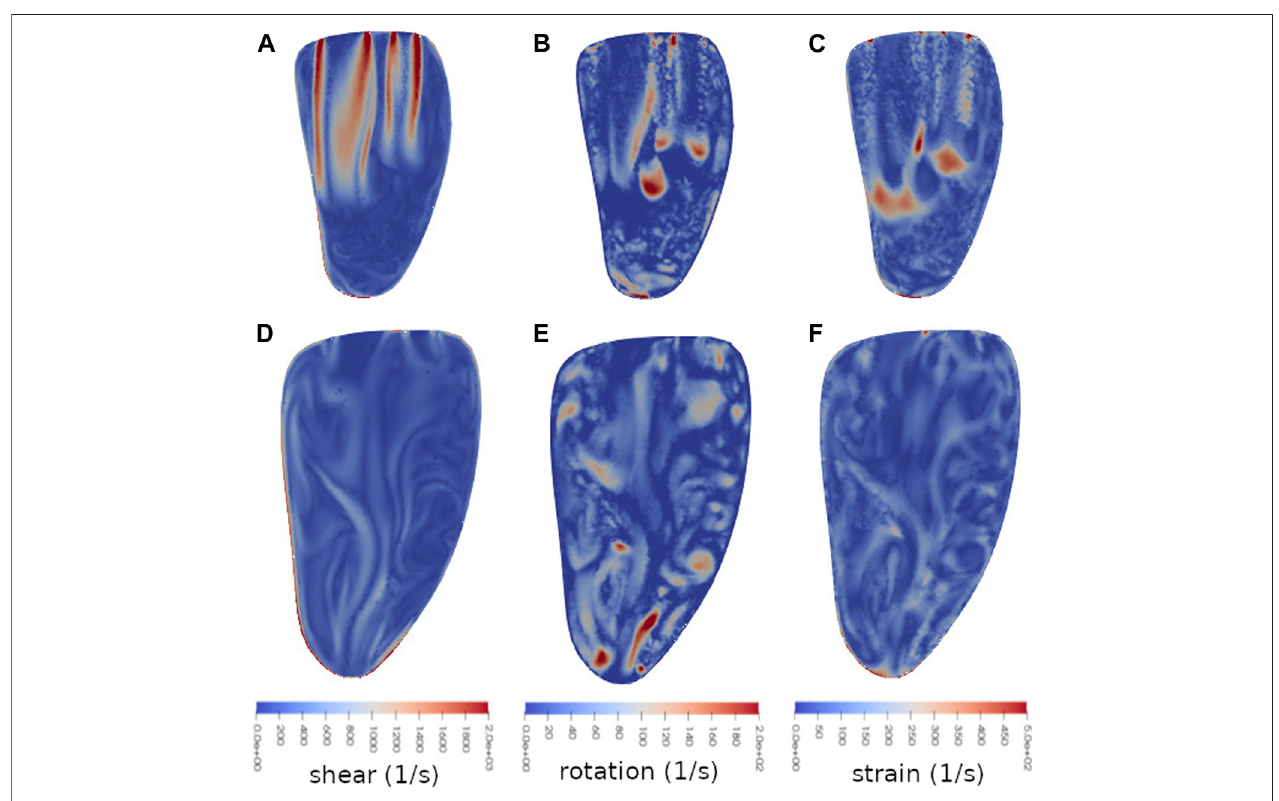
FIGURE7| Snapshotsofshear (A and D) ,rotation (B and E) andstrain (C and F) attwotimesduringdiastole: t =0.45 s (A,B and C) and t =0.71 s (D,E and F) ina verticalbicommissuralcutthroughtheleftventricle.ThissimulationwasdonewithMVCplacedat s · l fromthecenterofthecoaptationline,with l beingthelongaxisinthe MVmodel,andthepositionscalefactor s =0.2.Attime t =0.45 s(earlydiastole),the fl owisdominatedbythetwoincomingE-wavejets.Thevelocityandpressureatthis time are shown in Figures 3C , 4C respectively. At time t = 0.71 s (end diastasis) the in fl ow jets are weaker, and the initial dominant fl ow structures of the E-wave have started to break down. Note that the different sizes of the ventricle are due to the diastolic expansion.